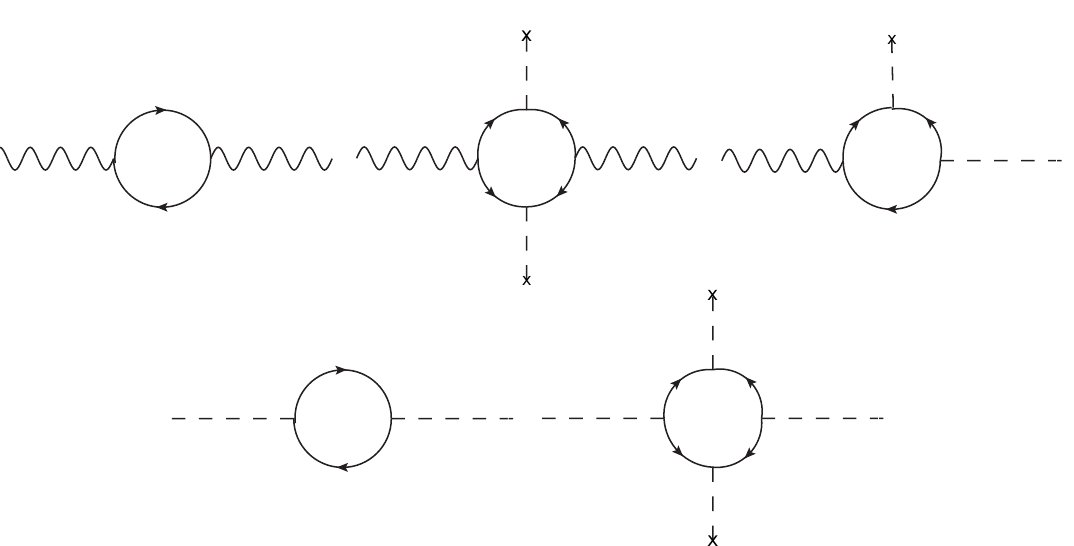
Figure 2 . Diagrams contributing to the self-energy diagrams before the U(1) spontaneously